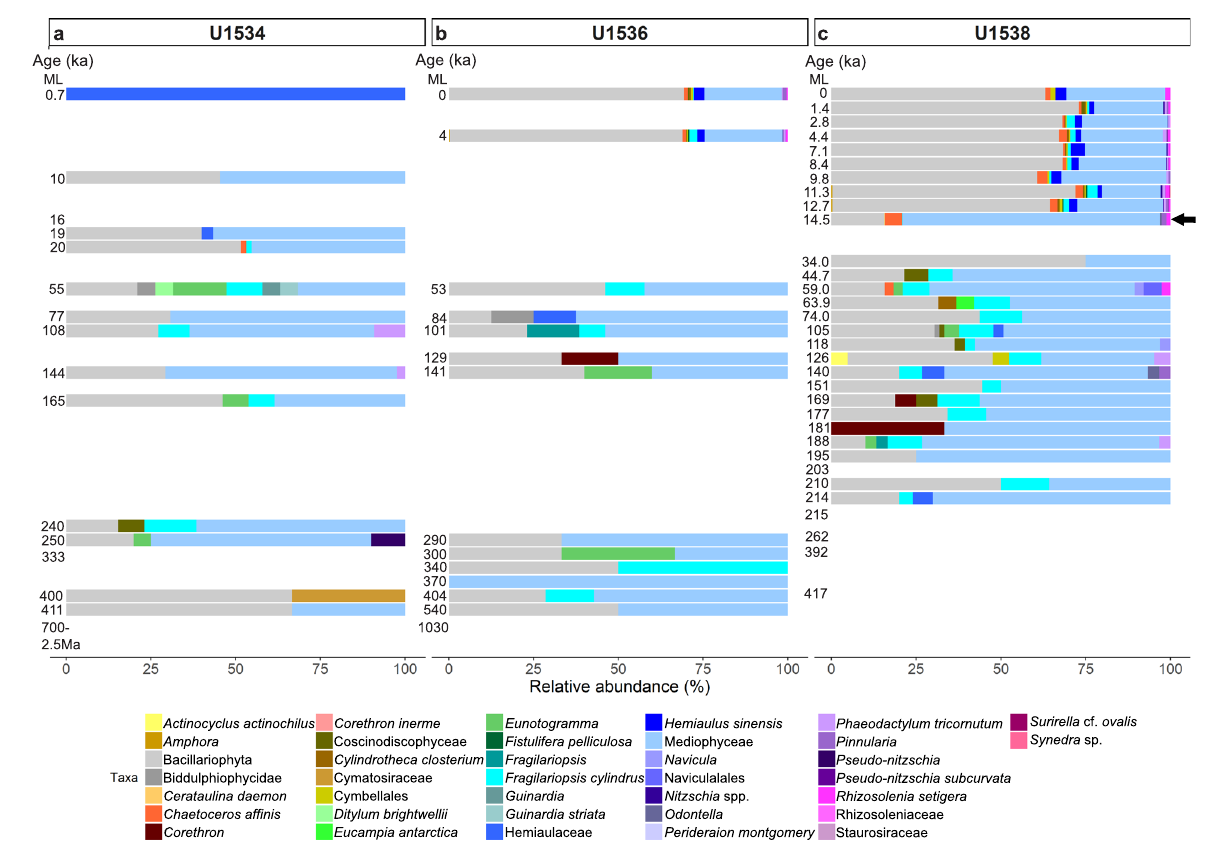
Fig. 5|Relativediatom abundanceatIODP Exp.382SitesU1534, U1536,U1538. Relative abundance of diatoms is shown at lowest taxonomic level resolved from sed aDNAatExp.382SitesU1534(HoleC)( a ),U1536(HoleB)( b )andU1538(HolesC and D) ( c ), post combined SSU+LSU alignment. Left axis shows the estimated age (whereanagebutnobarisshown,nodiatomreadswereidenti fi edinthatsample).